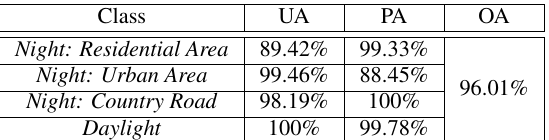
Table 3: Quality measures overall accuracy (OA), user’s accuracy (UA) and producer’s accuracy (PA) for evaluation of the illumi- nation recognition for whole